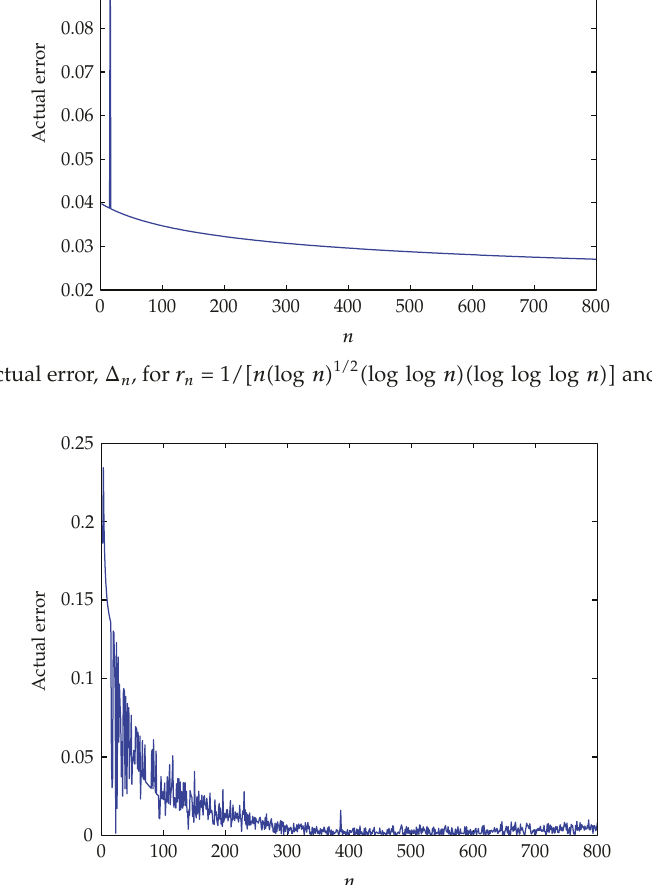
Figure 6: T he actual error, Δ n , for r n (cid:4) 1 / (cid:5) n (cid:2) log n (cid:3) 1 / 2 (cid:2) log log n (cid:3)(cid:2) log log log n (cid:3)(cid:6) and (cid:2) x,y (cid:3) (cid:4) (cid:2) 1 , 1 (cid:3)